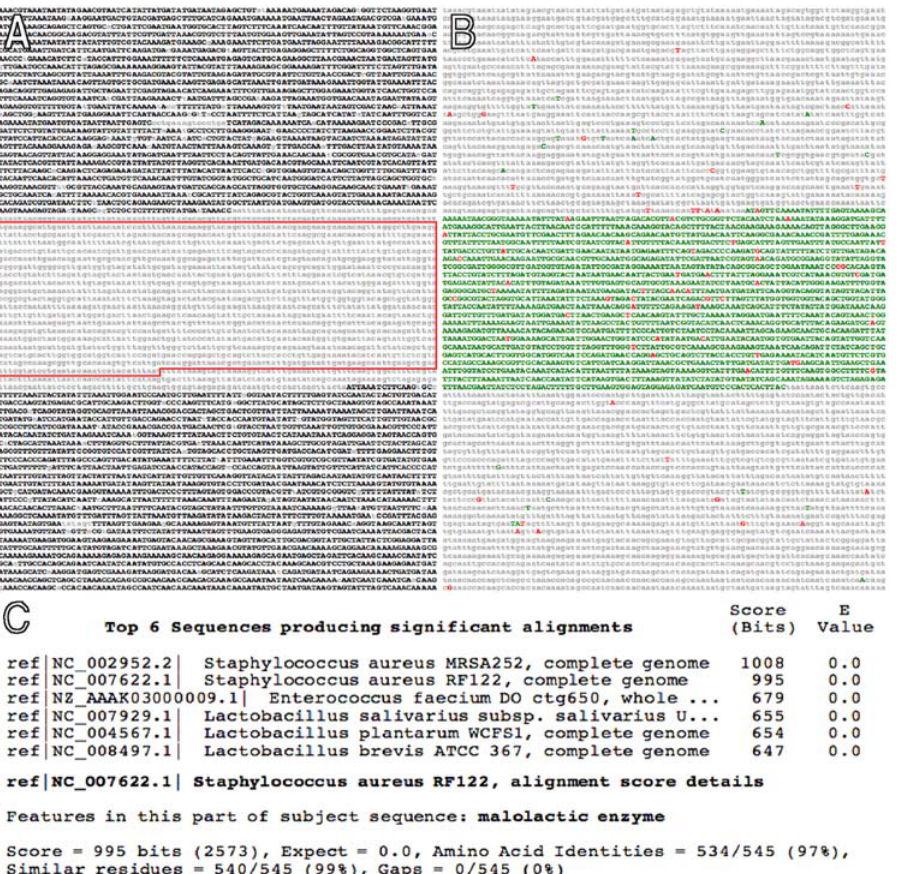
Figure 2. EvoPrint and EvoUnique comparative analysis of 13 different S.aureus isolates reveals that only the human MRSA252 and contagious bovine mastitis RF122 chromosomes contain the malolactic enzyme gene. A ) An EvoPrint generated from pairwise alignments of MRSA252 DNA (6,497 bp) and aligning regions from 12 other S. aureus genomes ( S. aureus COL; S. aureus MSSA476, S. aureus Mu50; S. aureus MW2; S. aureus N315; S. aureus NCTC 8325; S. aureus RF122; S. aureus USA300; S. aureus JH1; S. aureus JH9; S. aureus Mu3 and S. aureus Newman) reveals high homology between all aligning regions except for a central 1,981 bp region. Uppercase black-colored letters identify MRSA252 sequences that align with all genomes and lowercase gray-colored bases indicate nucleotides that do not align with at least one of the genomes. The boxed ORF sequence encodes the 545 amino acid malolactic enzyme. B ) Generated from the same analysis, the MRSA252 EvoUnique print indicates that only one of the 12 genomes included in the analysis contains homologous sequences that span the MRSA252 malolactic enzyme gene locus (SAR0824). Uppercase red-colored SNPs are unique to the MRSA252 sequence; green-colored letters represent bases that align with only one of the 12 genomes ( S. aureus RF122) and lowercase gray-colored letters represent sequences that are common to two or more alignments. ( C ) Protein database homology searches identify the RF122 malolactic enzyme as sharing the highest identity with the MRSA252 enzyme. Note: no homologies to other malolactic enzyme encoding genes were detected in other S. aureus species.